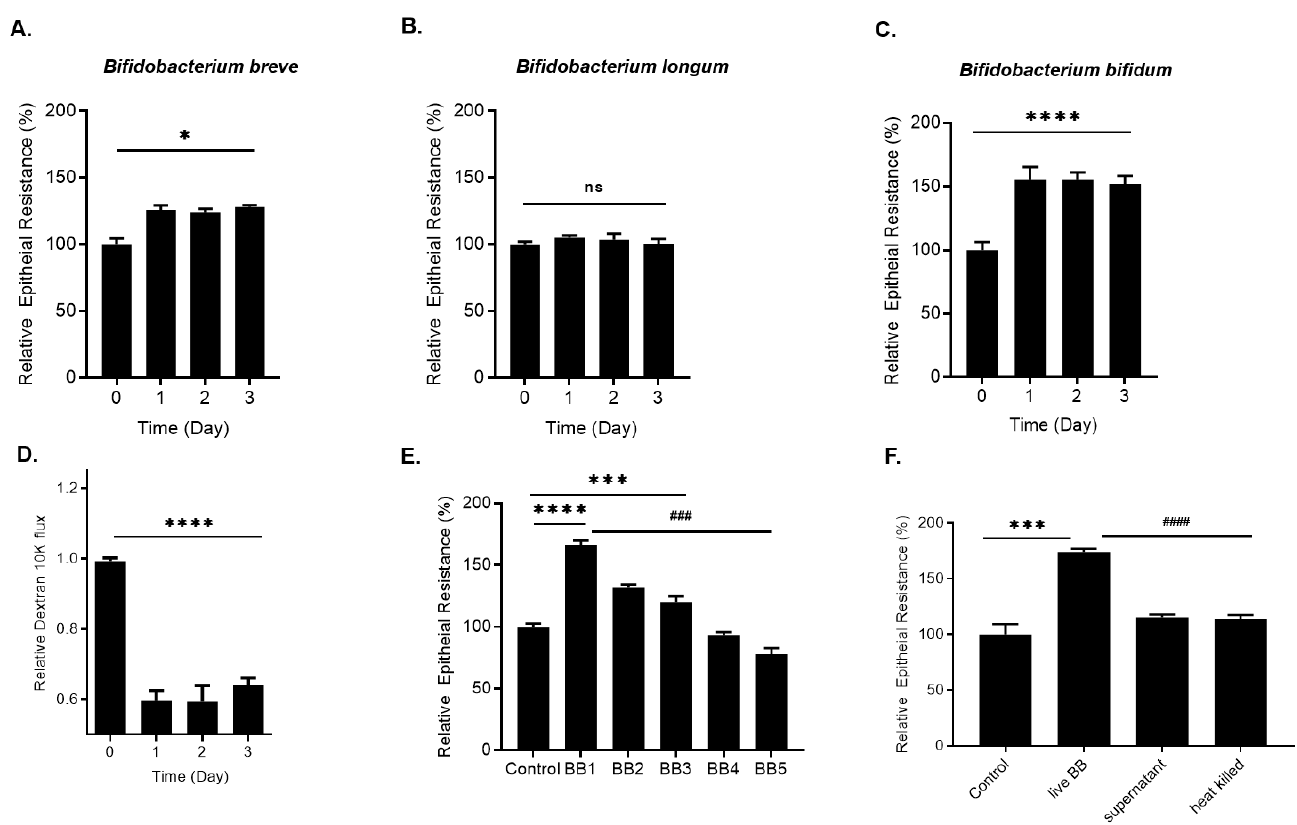
Figure 1. Effect of Bifidobacterium species and strains (1 × 10 8 CFU/mL) on filter-grown Caco-2 TJ permeability. ( A ) Time- course effect of Bifidobacterium breve, ( B ) Bifidobacterium longum, and ( C ) Bifidobacterium bifidum on Caco-2 TER; * p < 0.05 vs. control; **** p < 0.0001 vs. control. ( D ) Time-course effect of Bifidobacterium bifidum (BB) on Caco-2 mucosal-to-serosal flux of paracellualr marker dextran 10 kDa; **** p < 0.0001 vs. control. ( E ) Strain BB1 caused a 50–80% increase in Caco-2 TER, BB2 and BB3 strains caused a ~25% increase in Caco-2 TER, but BB4 and BB5 did not enhance Caco-2 TER over the 3-day experimental period; **** p < 0.0001 vs. control; *** p < 0.001 vs. control. ### p < 0.001 vs. BB1. ( F ) Live BB1, but neither BB1 bacterial supernatant nor heat-killed BB1 caused an increase in filter-grown Caco-2 TER; *** p < 0.001 vs. control; #### p < 0.0001 vs. live BB1; ns: not